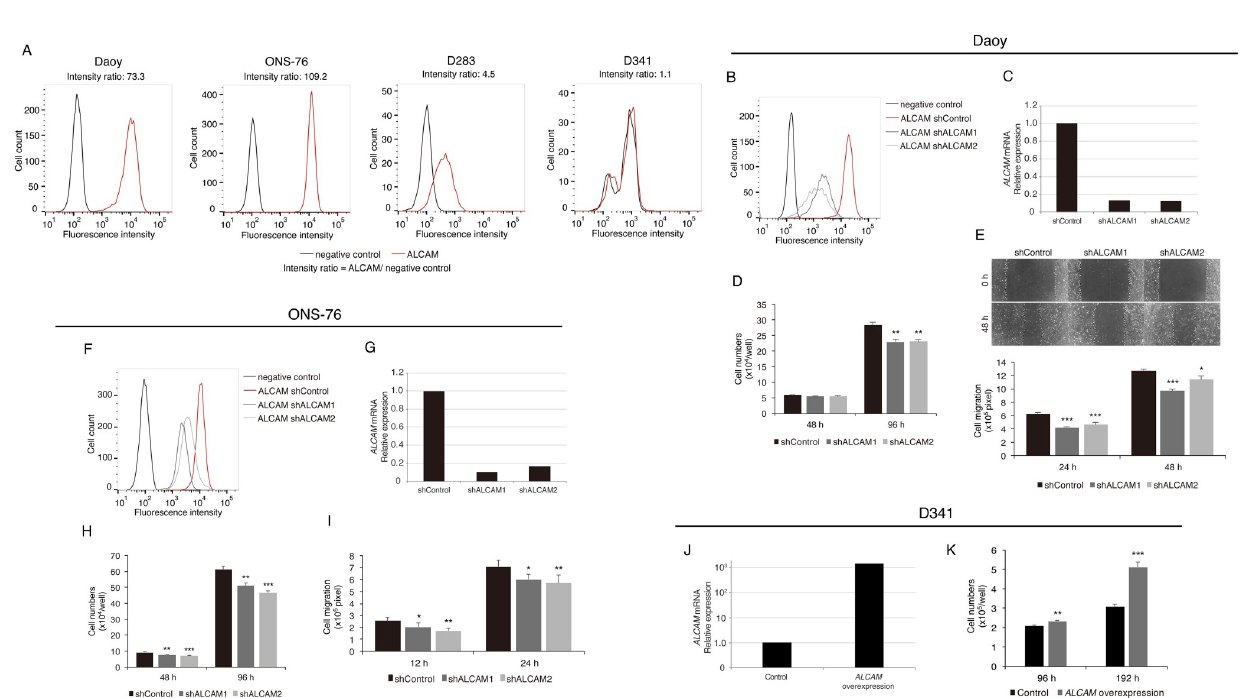
Fig 3. Expression of ALCAM in medulloblastoma (MB) cell lines and in vitro study of its function in Daoy and ONS-76 cells. (A) Four MB cell lines exhibited different ALCAM expression as measured by flow cytometry. (B, C, F, G) Knockdown of ALCAM in Daoy and ONS-76 cells was verified using flow cytometry (B, F) and qPCR (C, G). (D, E, H, I) ALCAM silencing inhibits the proliferation (D, H) and migration (E, I) of Daoy and ONS-76 cells. (J) Overexpression of ALCAM in D341 cells was confirmed by qPCR. (K) ALCAM overexpression promotes the proliferation of D341 cells. Data are reported as the mean ± SE. � : P < 0.05; �� : P < 0.01; ��� : P < 0.0001.